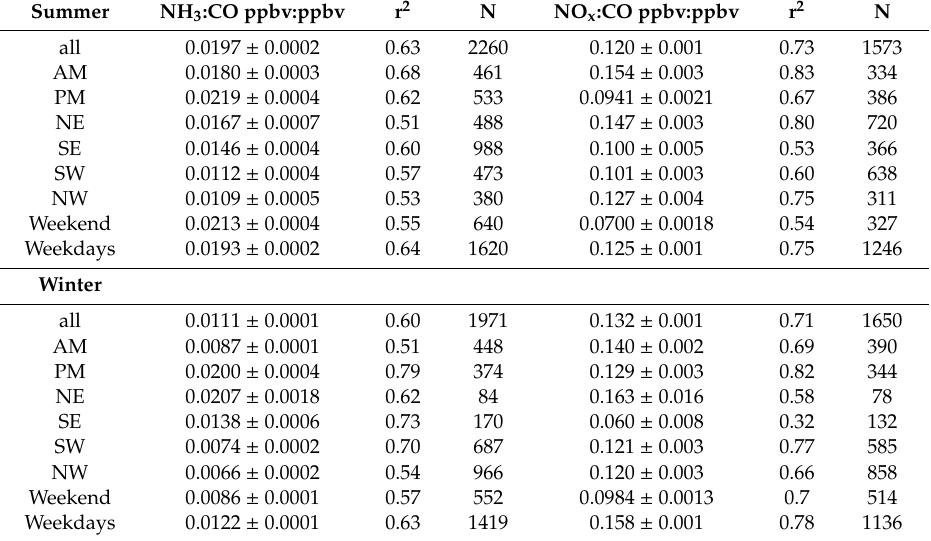
Table 6. The ratio of the measured NH 3 (ppbv) to CO (ppbv) derived from the slope ( ± standard error of the estimate) and r 2 of the weighted orthogonal distance regression (WODR). N is the number of points used in the